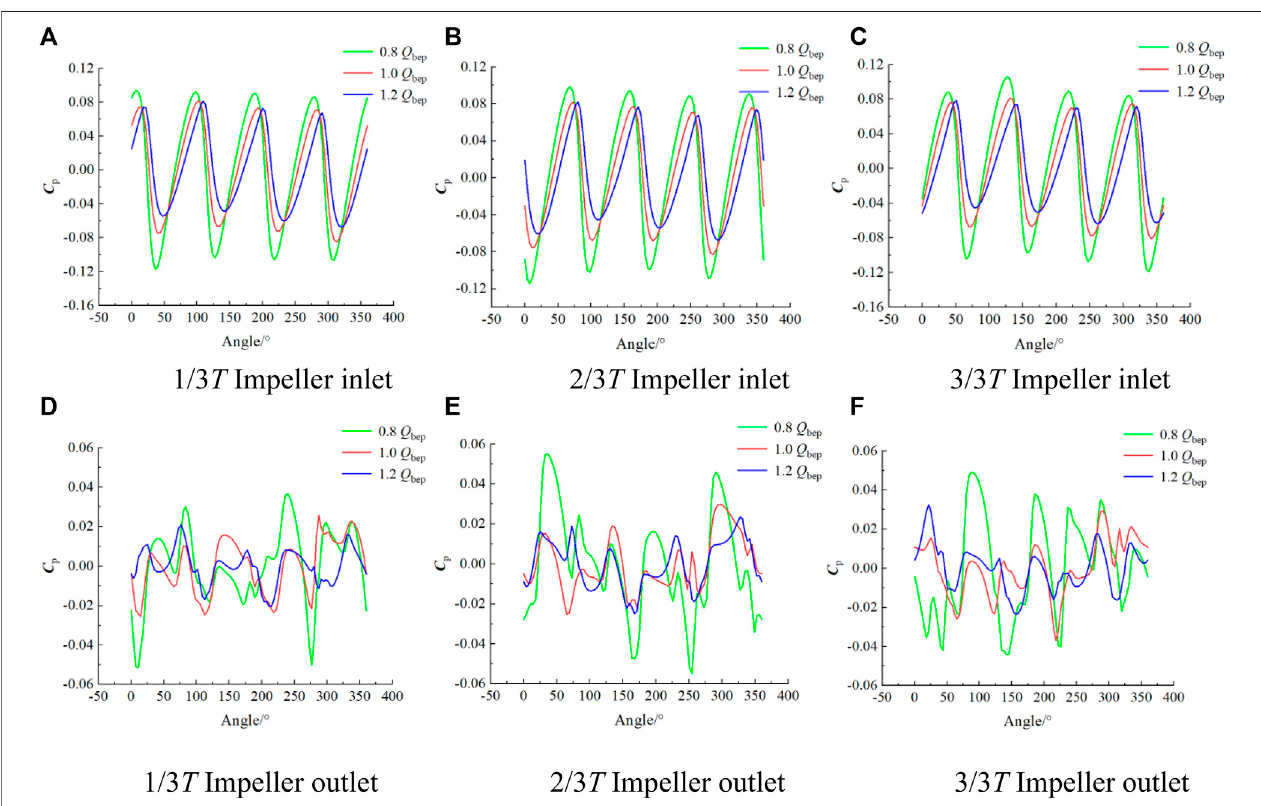
FIGURE 8 | Distribution of circumferential pressure coef fi cient of the impeller inlet and outlet at different time.